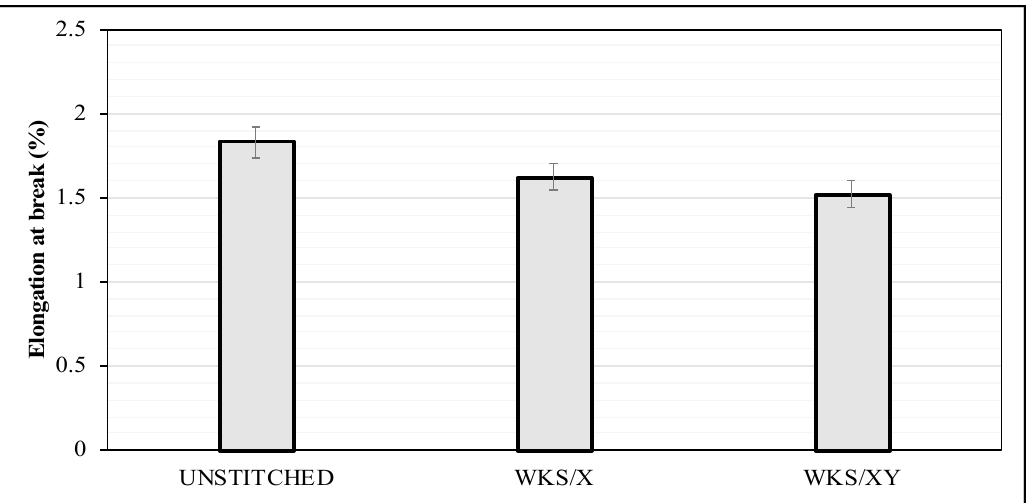
Figure 12. Effect of stitching density and pattern on the elongation at break of the unstitched and silk-fiber-stitched woven kenaf composites.